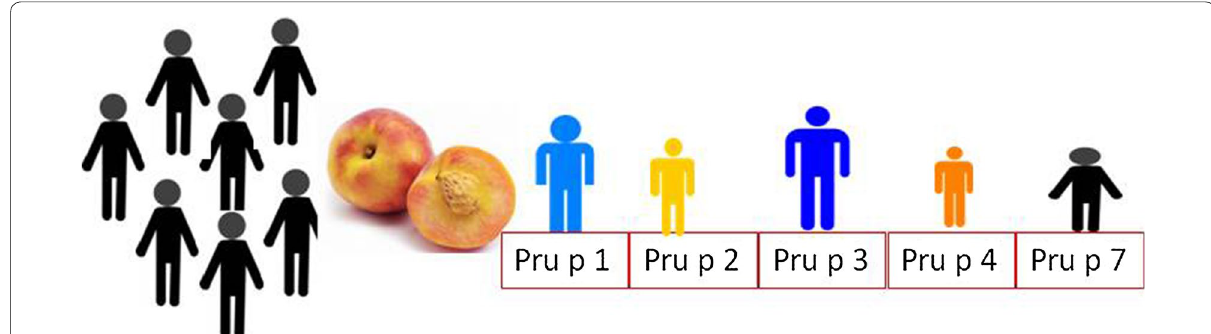
Fig. 3 Peach allergic patients: “one size does not fit